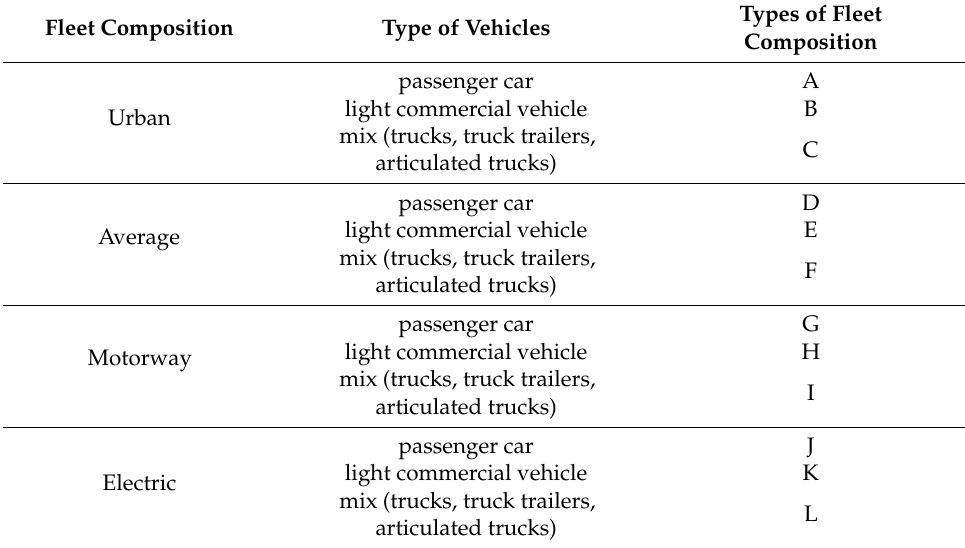
Table 2. Types of fleet